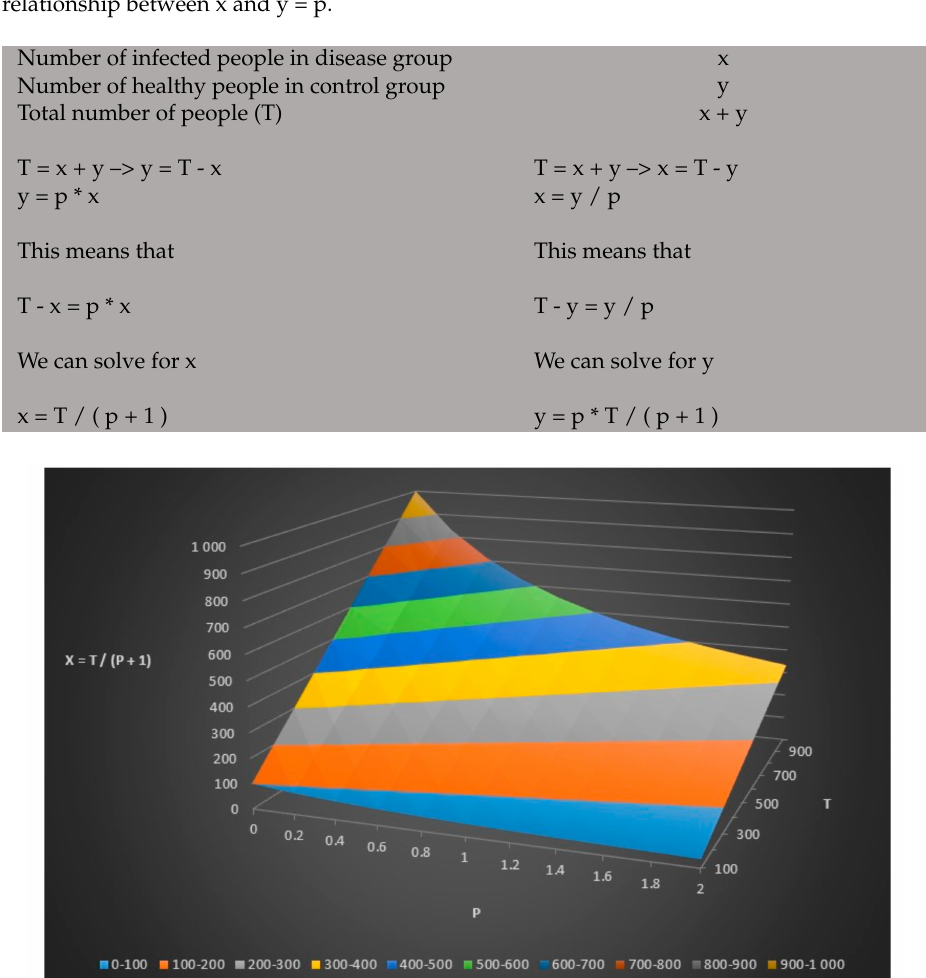
Table 4. The number of infected people in the disease group (x) given total number of people (T) and the relationship between x and y = p.